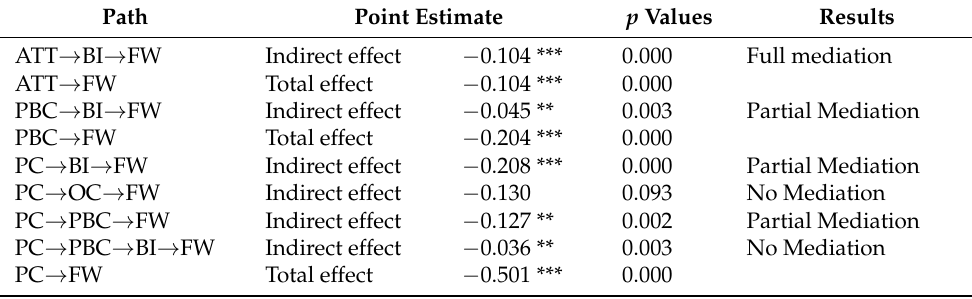
Table 6. Indirect and total effects of ATT, PBC and